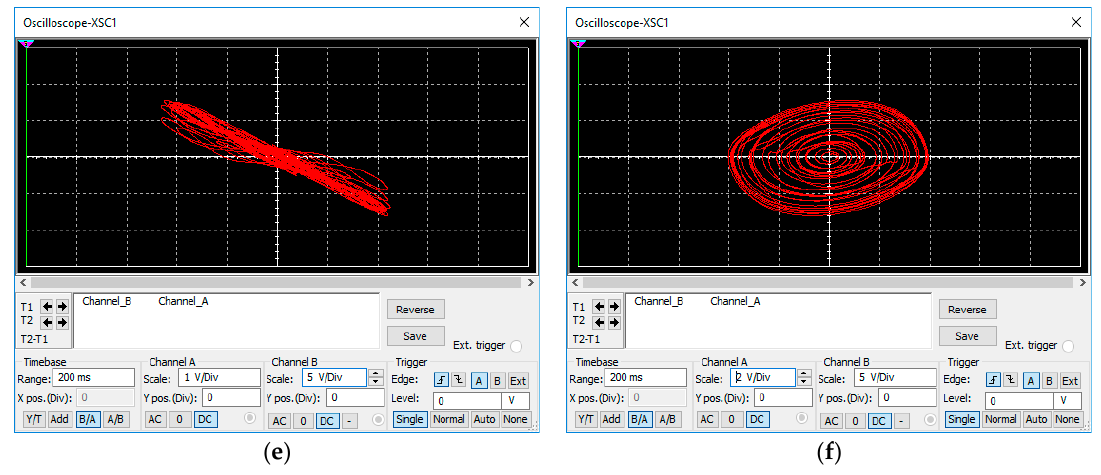
Figure 7. PSpice simulation results of system (8) in different phase portraits ( a ) x 1 – x 2 plane; ( b ) x 1 – x 3 plane; ( c ) x 1 – x 4 ; ( d ) x 2 – x 3 plane; ( e ) x 2 – x 4 plane and ( f ) x 3 – x 4 plane, for a = 3.8, b = 0.1 and c = 1.5 and initial conditions ( x 1 (0), x 2 (0), x 3 (0), x 4 (0)) = (0.1, 0.1, 0.1, 0.1).